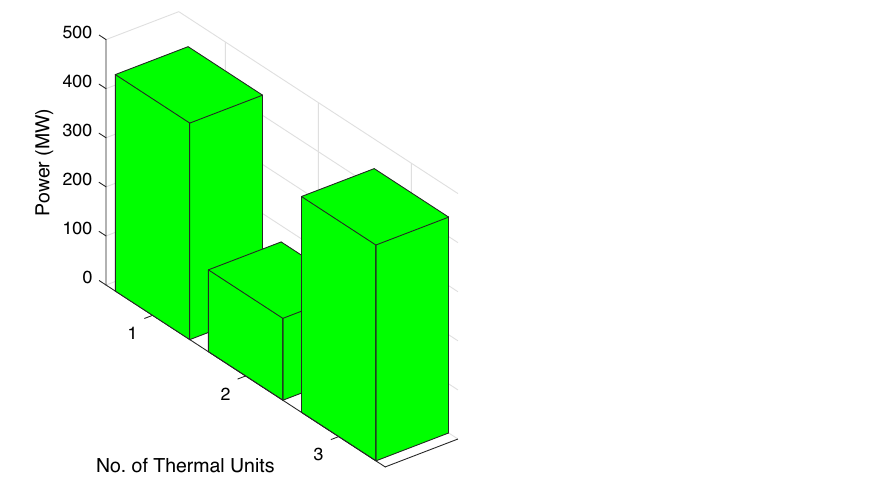
Figure 6. Optimum power generations for case study-I.